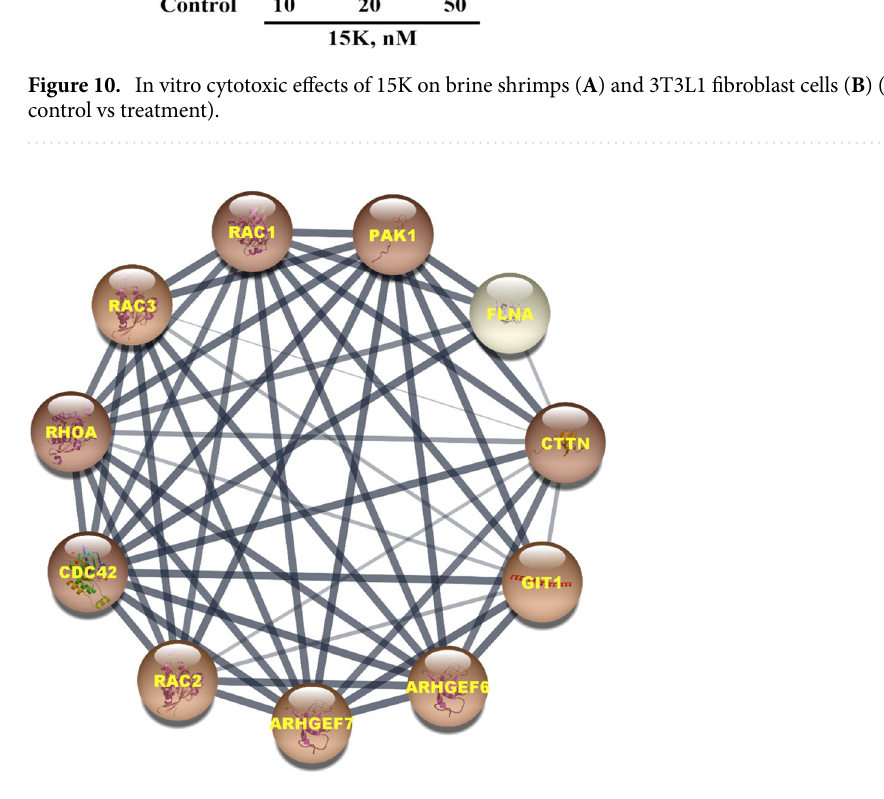
Figure 11. Protein–protein interaction network constructed with PAK1. Nodes with the dark color represents the highest degree value in the